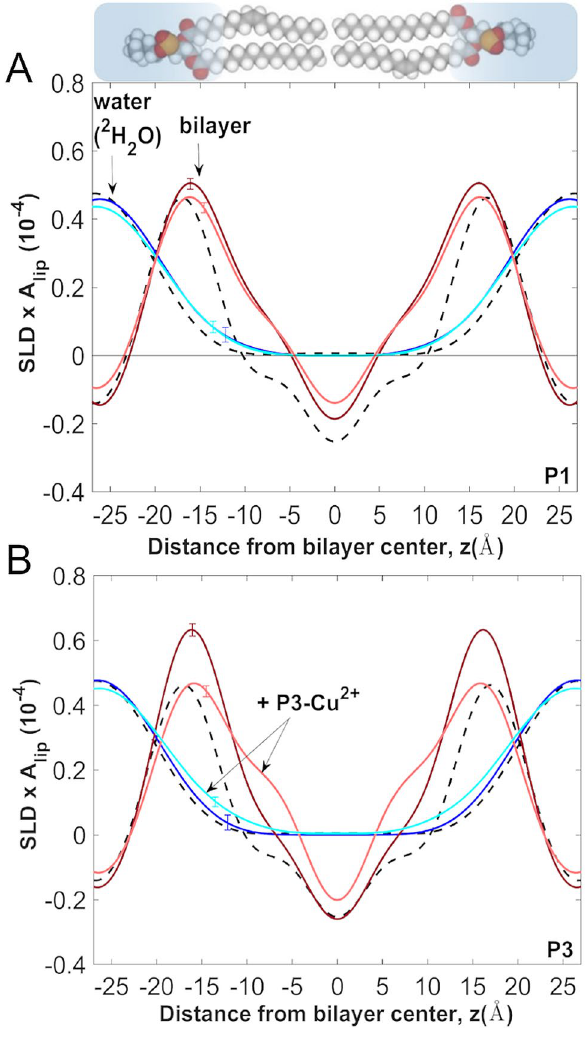
Figure 5. Bilayer scattering length density profiles from neutron diffraction on oriented lipid multilayers. ( A ) The scattering length density (SLD) profiles of the bilayer are shown as projections on the bilayer normal (z-axis) for POPC (black), P1/POPC (dark red), and P1-Cu 2+ /POPC (pink). The peptides were metallated using a 1:1 stoichiometric amount of CuCl 2 . The corresponding water profiles, determined from H 2 O/ 2 H 2 O contrast are overlaid for POPC (black), P1/POPC (dark blue), and P1-Cu 2+ /POPC (light blue). Peptides distribute equally on both sides of the bilayer during their incubation with liposomes and deposition on the substrate (see Methods). ( B ) Same as in ( A ) but for P3. All oriented samples were prepared in POPC at P/L = 1:25, and measured at 23 °C and 93% relative humidity achieved by using the vapor phase of saturated salt solutions. The small error bars on the curves represent the uncertainty in the profiles, which were calculated using a 95% confidence interval in the Monte-Carlo sampling of the structure factors 87 . Structure factors and standard deviations are given in Table S2. All profiles were determined on a per-lipid scale using structure factors calibrated to reflect the composition of the unit cell and without explicitly determining the area per lipid 87